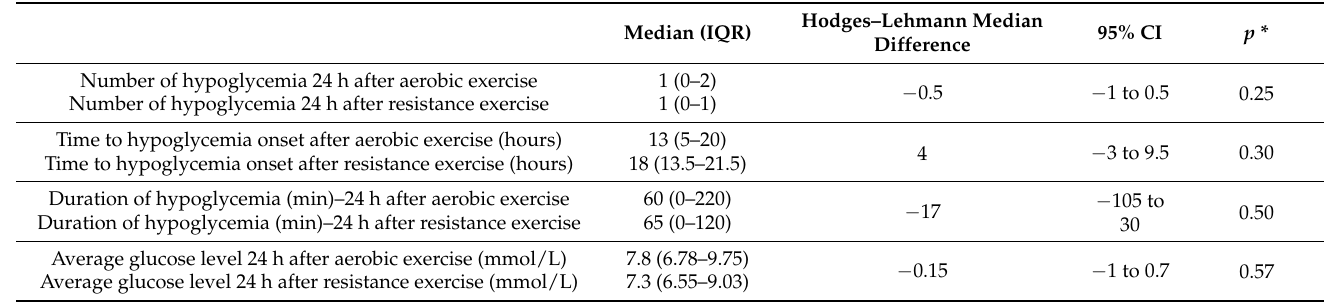
Table 4. Differences in the number and duration of hypoglycemic episodes and average glucose level 24 h after training, depending on the type of exercise; data extracted from IsCGM.